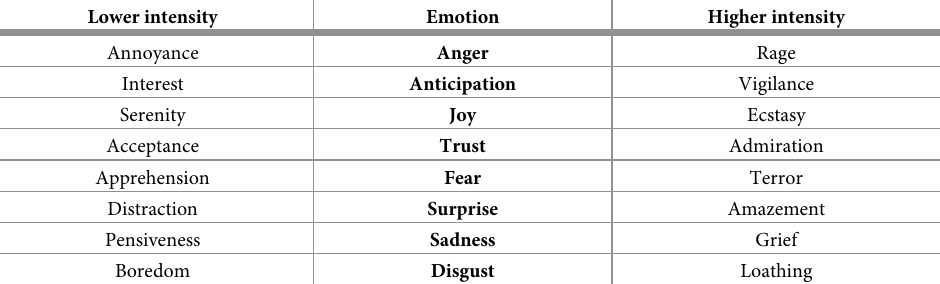
Table 1. Plutchik’s 8 basic emotions with 3 degrees of intensity each. Emotions are commonly referred as the middle intensity degree ones.